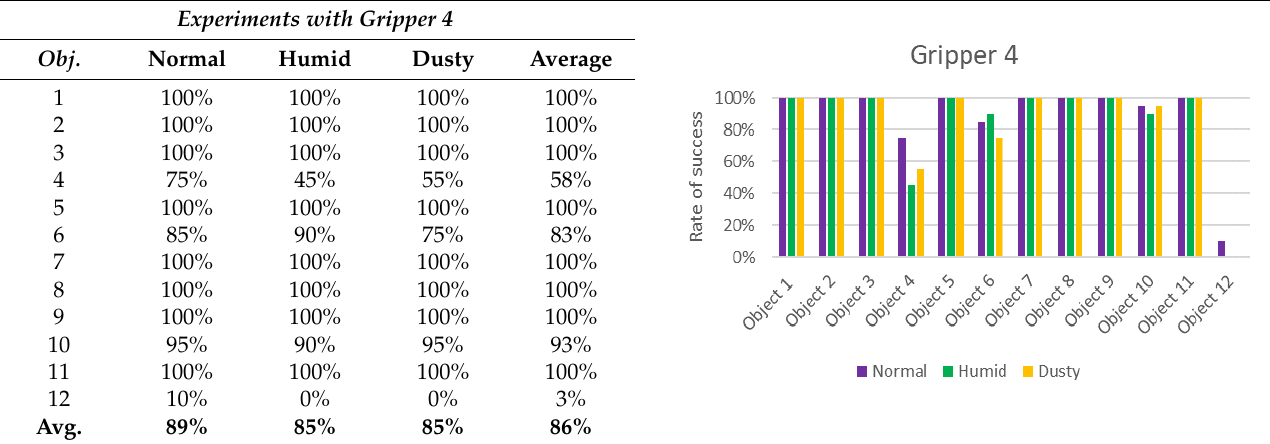
the right, the graphic representation of Table 5 is reported.